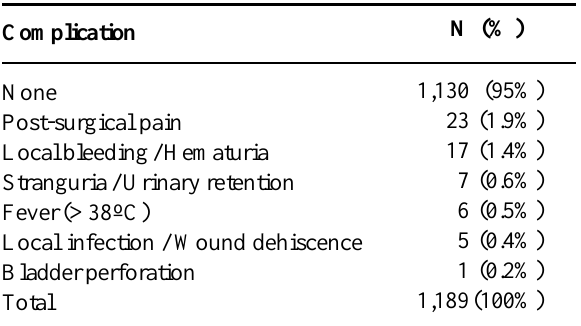
Table 3 – Distribution of complications.